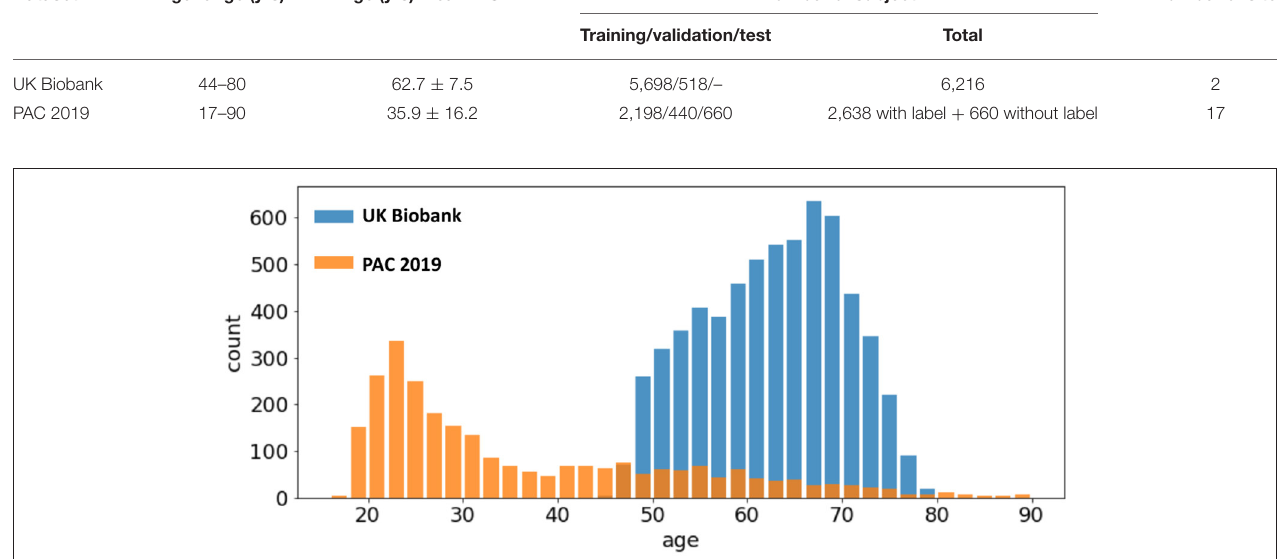
TABLE 1 | Difference in age distribution between PAC 2019 used in this study and UK Biobank dataset used in Peng et al. (24). Dataset